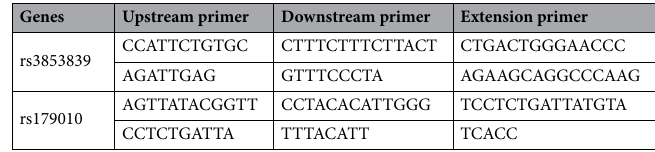
Table 1. Primer information and primer sequences of